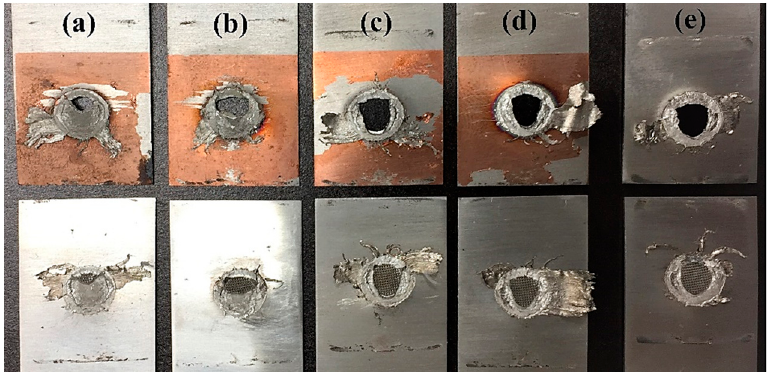
Figure 5. Failed samples after lap shear tensile testing for joint type B at ( a ) 900 J; ( b ) 1000 J; ( c ) 1100 J; ( d ); 1200 J; and, ( e ) joint type A at 1400 J USW energy.